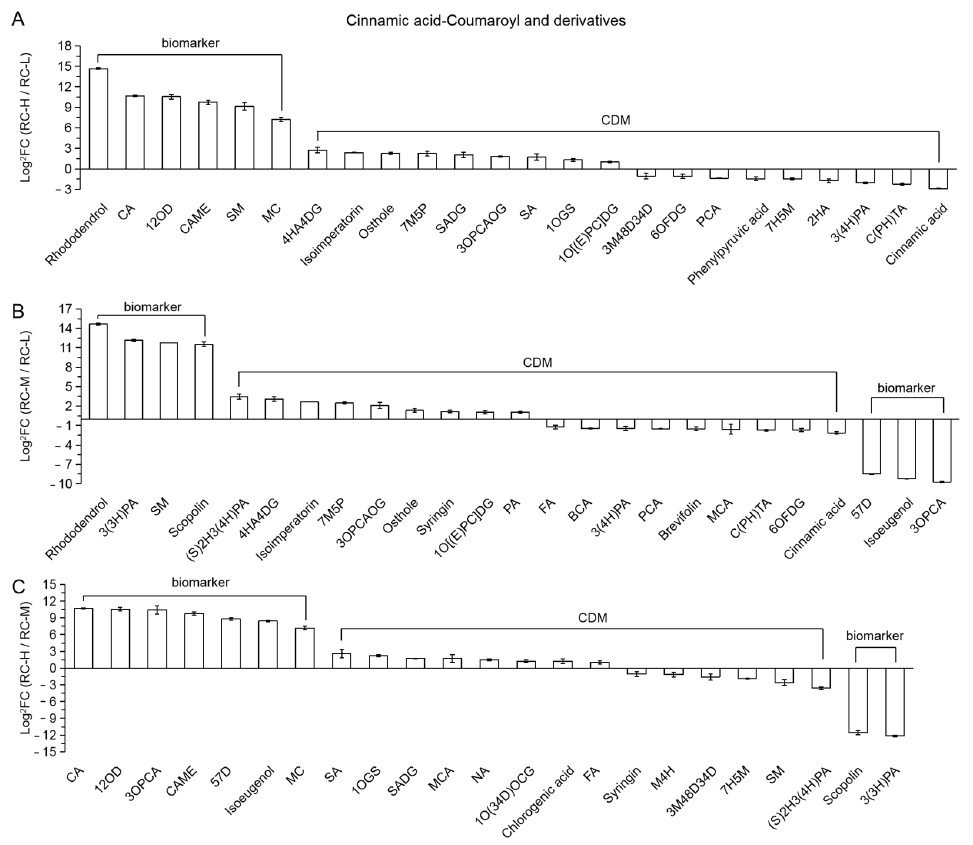
Figure 12. Comparison of differential metabolites of Cinnamic acid-Coumaroyl and its derivatives between RC-L, RC-M and RC-H. These were 6 biomarkers and 18 CDMs for RC-H vs. RC-L ( A ), 7 biomarkers and 18 CDMs for RC-M vs. RC-L ( B ), and 9 biomarkers and 14 CDMs for RC-H vs. RC-M ( C ). Upregulation denotes that the content of a metabolite in RC increased with elevation between two altitudes, and the opposite for downregulation. The Y-axis is shown as Log 2 FC values for the convenience of visual presentation (Note: The up-amplitude in the text refers to the FC value). The X-axis denotes metabolite names.